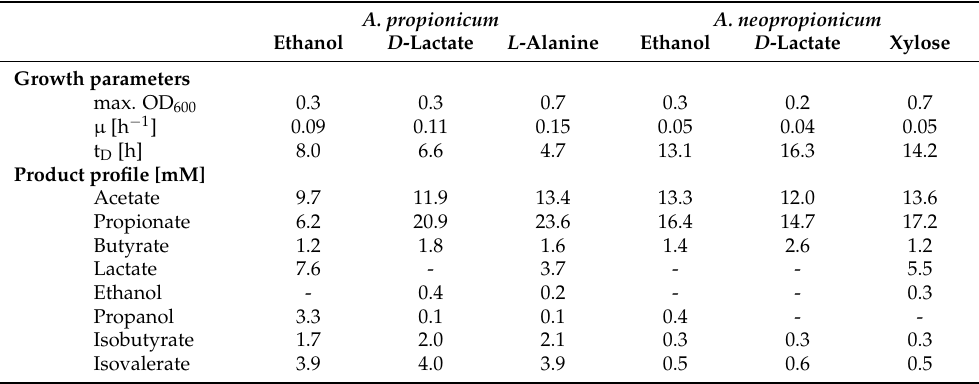
Table 2. Overview of growth parameters and product profiles of A. propionicum and A. neopropionicum when cultivated with different carbon sources. Product concentrations refer to the mean titers at the end of cultivation ( n = 3). µ , growth rate; t D , doubling time; -, product not detected. A. propionicum A. neopropionicum Ethanol D -Lactate L -Alanine Ethanol D -Lactate Xylose Growth parameters max. OD 600 0.3